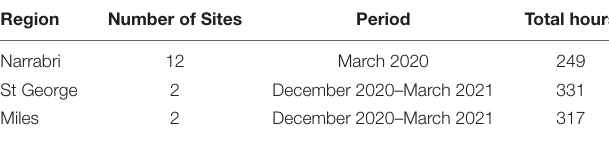
TABLE 2 | Recording period for training data. Region Number of